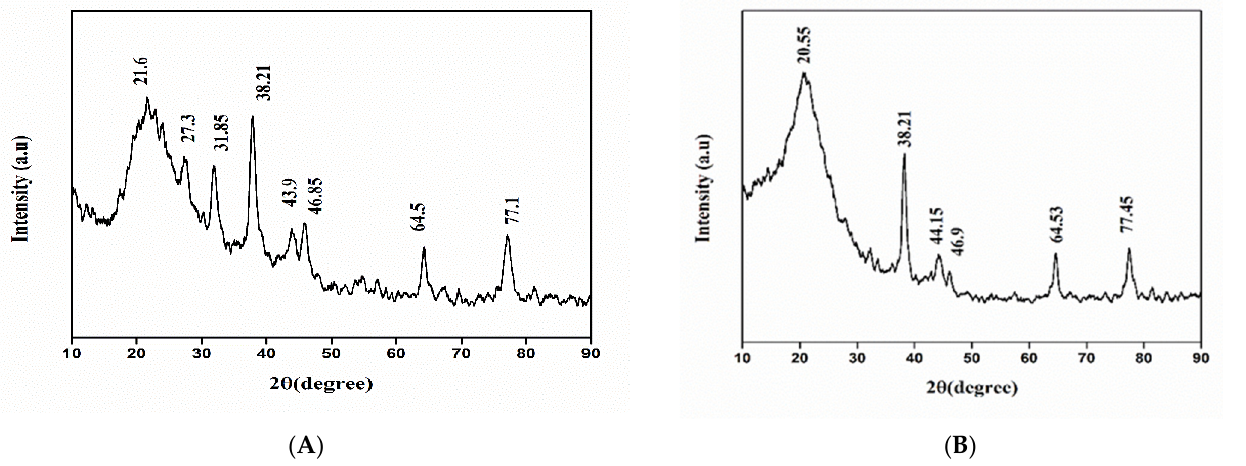
Figure 3. XRD pattern of silver nanoparticles synthesized using Acer oblongifolium extract. ( A ) Synthesized from 25 mM solution of AgNO 3 , ( B ) synthesized from 1 M solution of AgNO 3 .